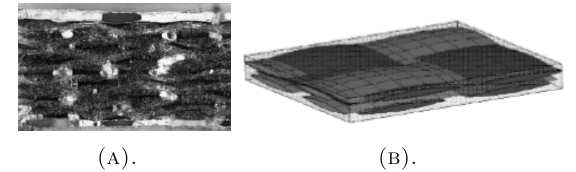
Figure 3. 2-fiber PUC - PUC-1.